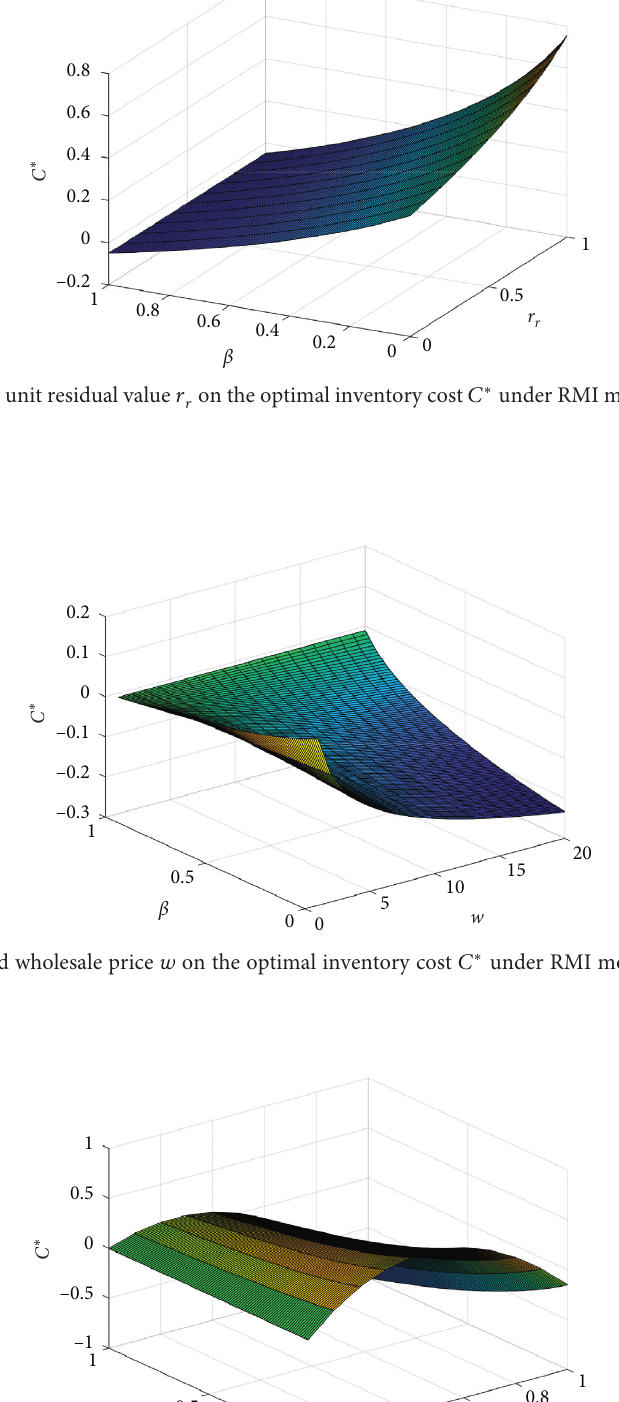
C ∗ under RMI mode with stochastic demand in the r on the optimal inventory cost